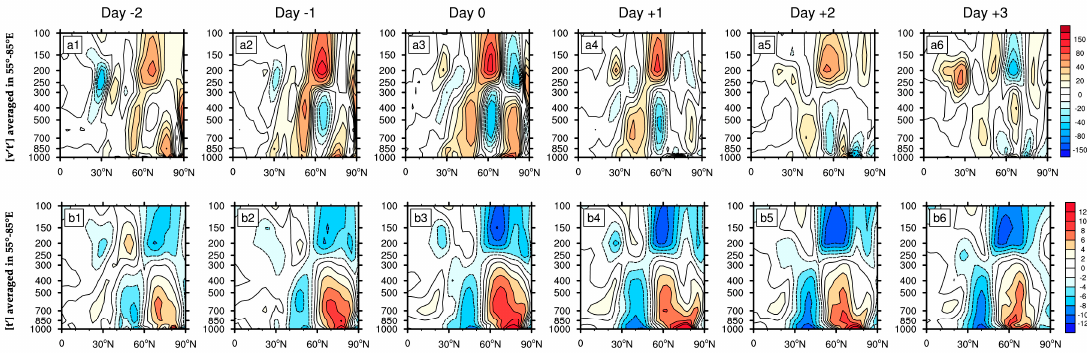
Figure 4. Pressure-latitude cross section in blocking high areas of the mean [ v'T' ] (unit: m s − 1 K) and the anomaly temperature [ T’ ] distribution (unit: K). (a1–a6, b1–b6 indicate the [ v’T’ ] (unit: m s − 1 K) and [ T’ ] (unit: K) averaged in 55°–85°E from January 16 to 21 in 2008, respectively.)